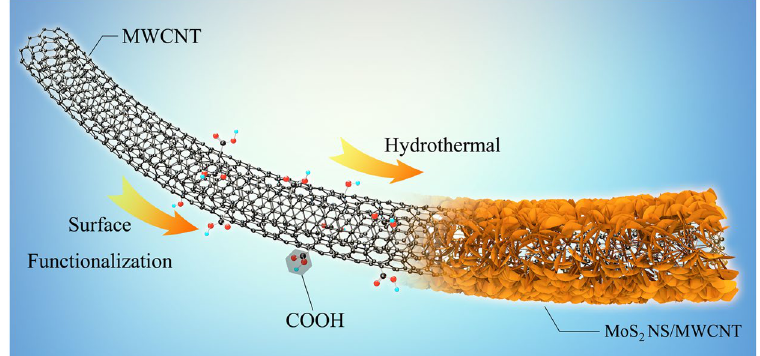
Figure 1. Schematic illustration of synthesis process for MoS 2 NS/MWCNT hybrid.